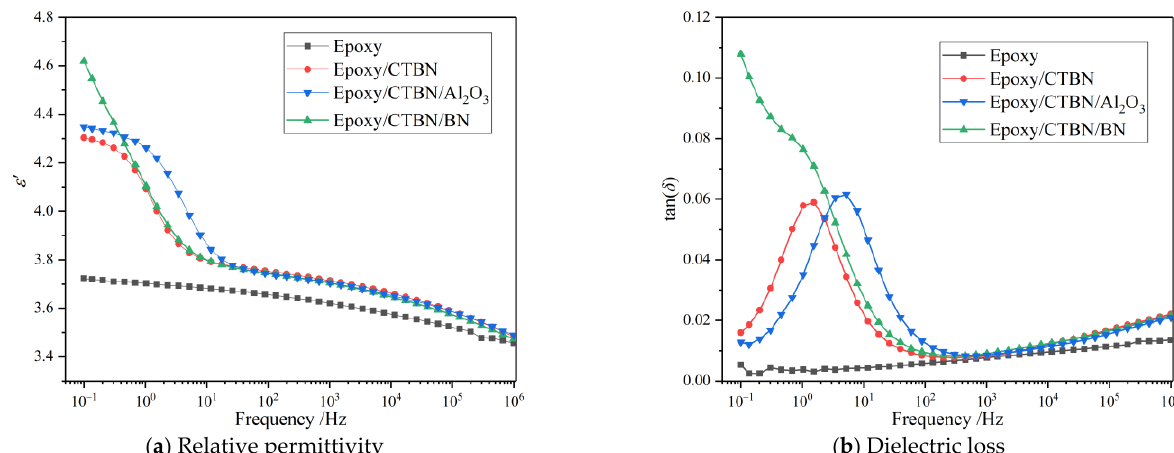
Figure 5. Frequency spectrum of relative permittivity and dielectric loss of four kinds of samples at 25 ◦ C. ( a ) Relative permittivity ( ε ′ ); ( b ) Dielectric loss (tan δ ).